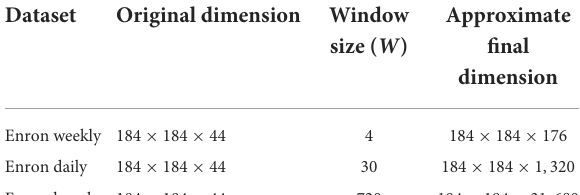
TABLE 2 Table of semi-synthetic datasets analyzed.